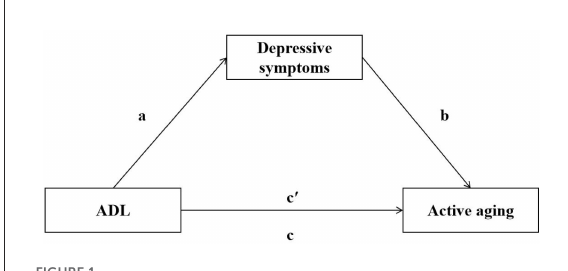
FIGURE1 Hypothesis of mediating role of depressive symptoms in ADL and active aging. a, b, c’, c represent path coefficients.